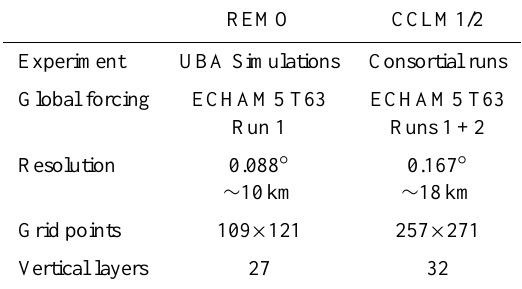
Table 1. Technical description of the REMO and CCLM regional climate models from which results are used in this study.